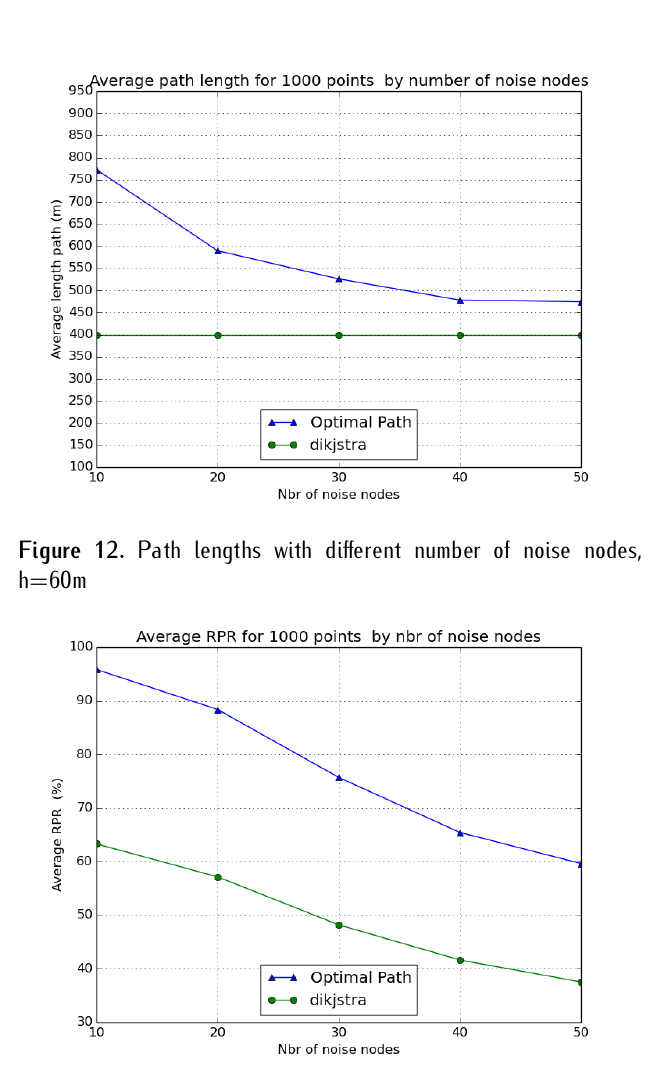
Figure 13. Received Packets Rate with different number of noise nodes, h=60m